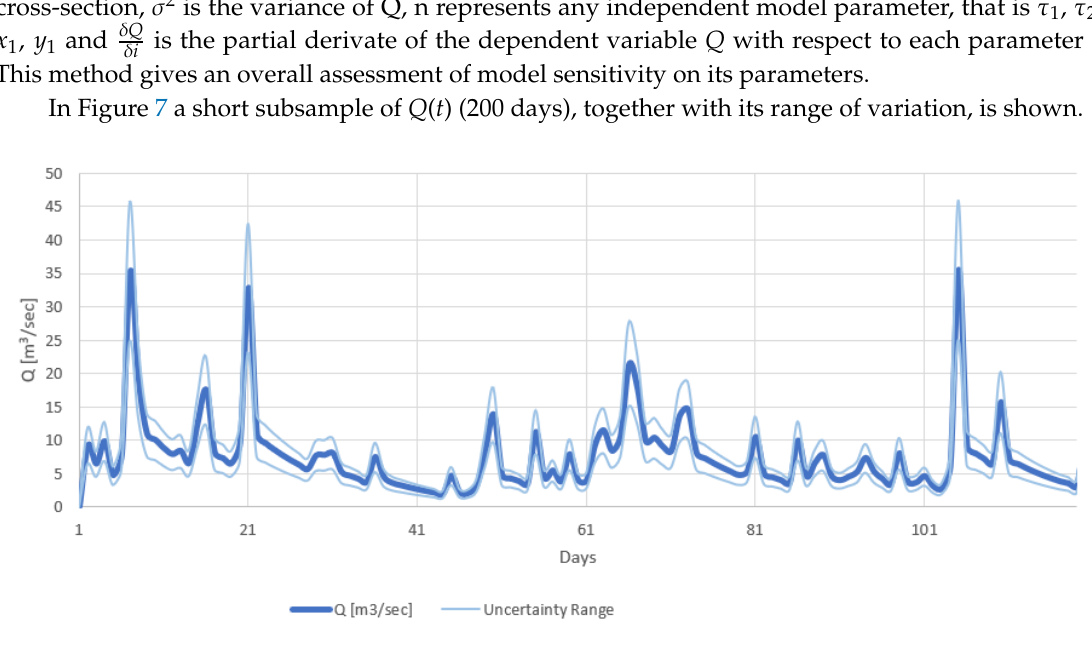
Figure 7. Uncertainty analysis in the assessment of the total discharge Q( t ) based on first-order sensitivity analysis on model parameters.